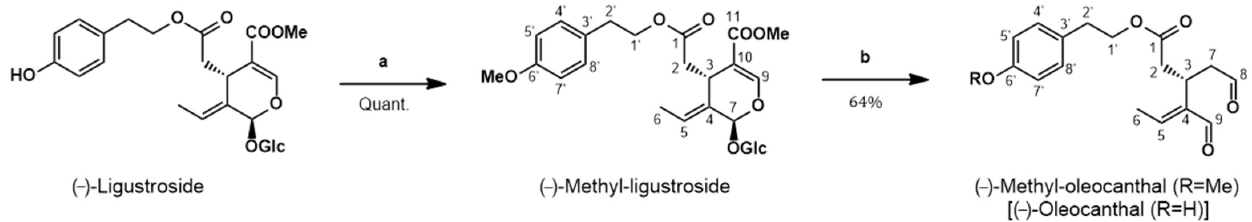
Figure 1. Synthesis of ( − )-methyl-oleocanthal from ( − )-ligustroside. Reagents and conditions: ( a ) CH 2 N 2 /Et 2 O; ( b ) H 2 O-DMSO, MW, 180 °C, 9 min.